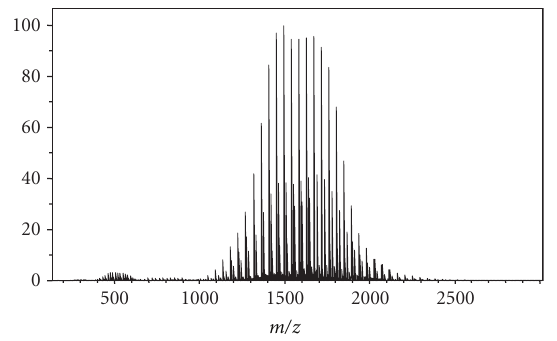
Figure 2: Polyethylene glycol paper spray mass spectrum; identifi- cation of oligomers as given in the literature